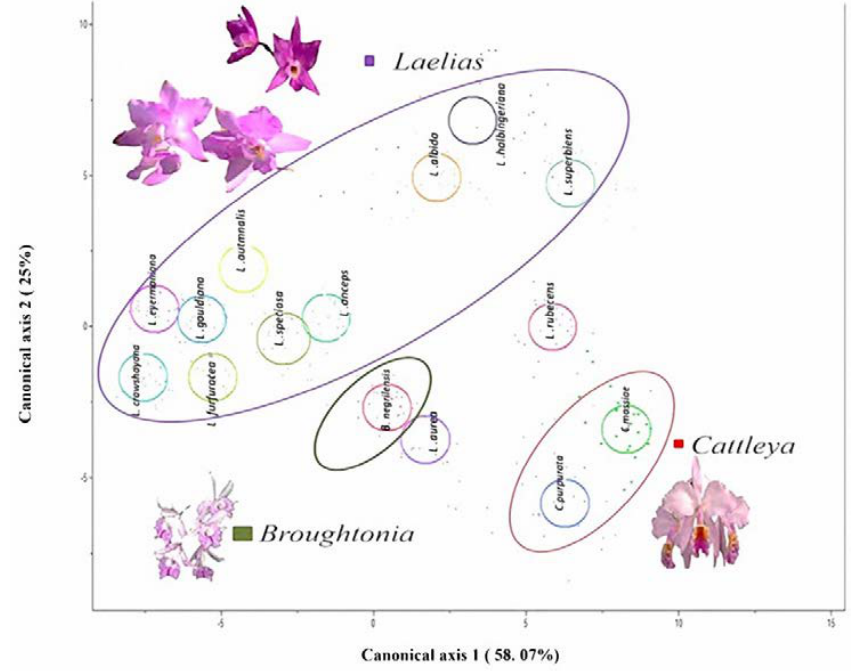
Figure 1. Canonical discriminant analysis (CDA) for the 15 species studied. Scatter diagram of points in the two-dimensional space of the CDA with 11 quantitative anatomical characters evaluated by species (canonical axis 1: 58.07%, canonical axis 2: 25%).